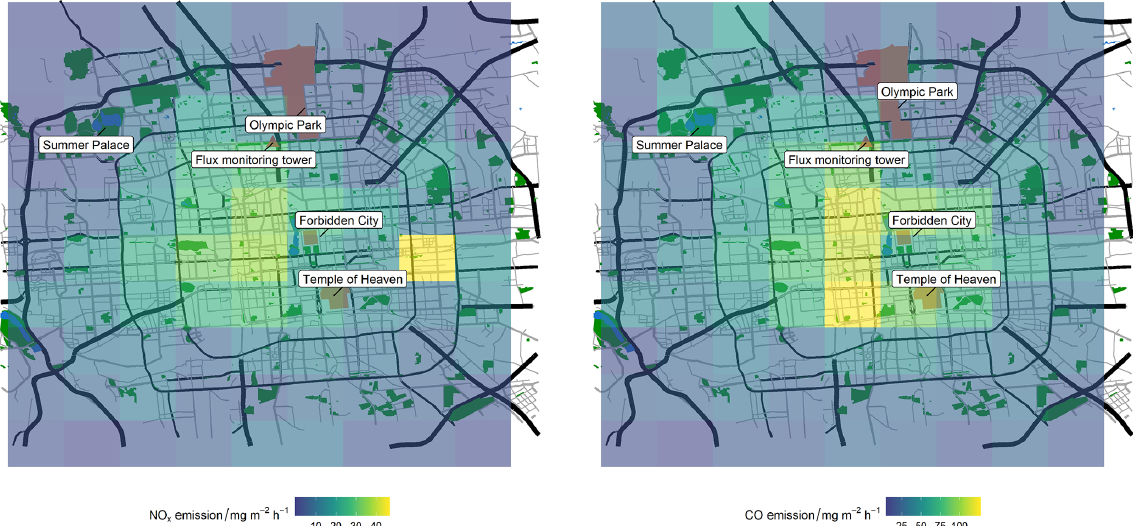
Figure A3. MEIC inventory emission grids for NO x and CO for November. Map was built using data from © OpenStreetMap contributors 2019. Distributed under a Creative Commons BY-SA